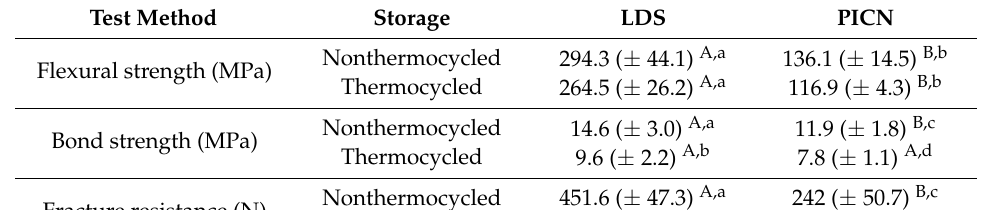
Table 2. Mean flexural-strength, bond-strength, and fracture-resistance values and standard deviations. Same capital superscript letters in the same row and same lowercase superscript letters in the same column indicate no significant differences within each test method ( p > 0.05).